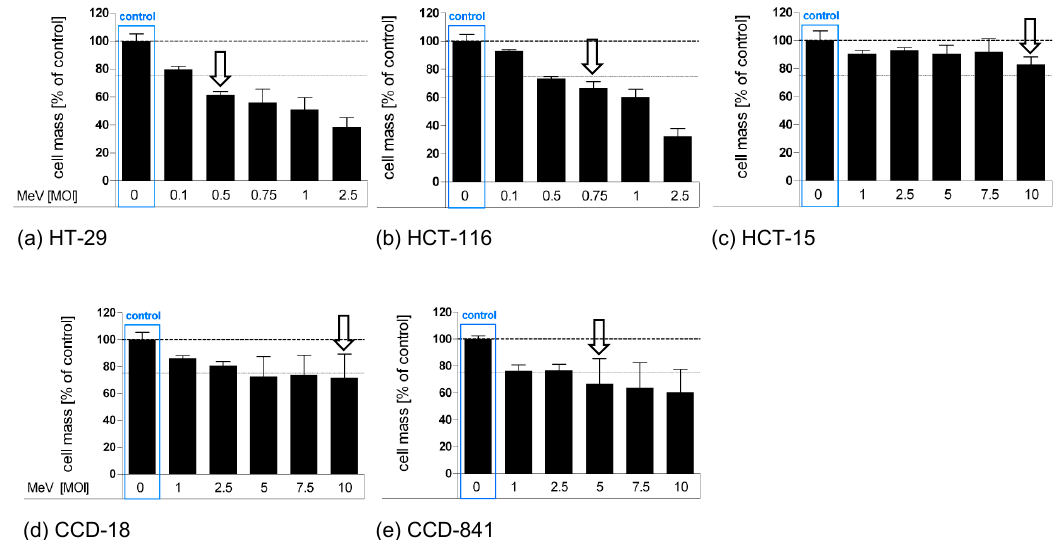
Figure 2. Susceptibilities of human colon carcinoma and normal human colon cells to MeV-mediated oncolysis. Human colon carcinoma cell lines HT-29 ( a ), HCT-116 ( b ), and HCT-15 ( c ) and normal colon cell lines CCD-18 Co ( d ) and CCD-841 CoN ( e ) were cultured in standard medium and infected 48 h after seeding in Opti-MEM ® (infection medium) with ascending multiplicities of infection (MOIs as indicated above) of MeV, or remained uninfected (control). At 96 h post-infection (hpi), the remaining tumor cell masses were determined by SRB viability assay. White arrows indicate selected MOIs which were used in further experiments to investigate a combined starvation plus virus-induced tumor cell toxicity. Means and standard error of the means (SEM) of two independent experiments are